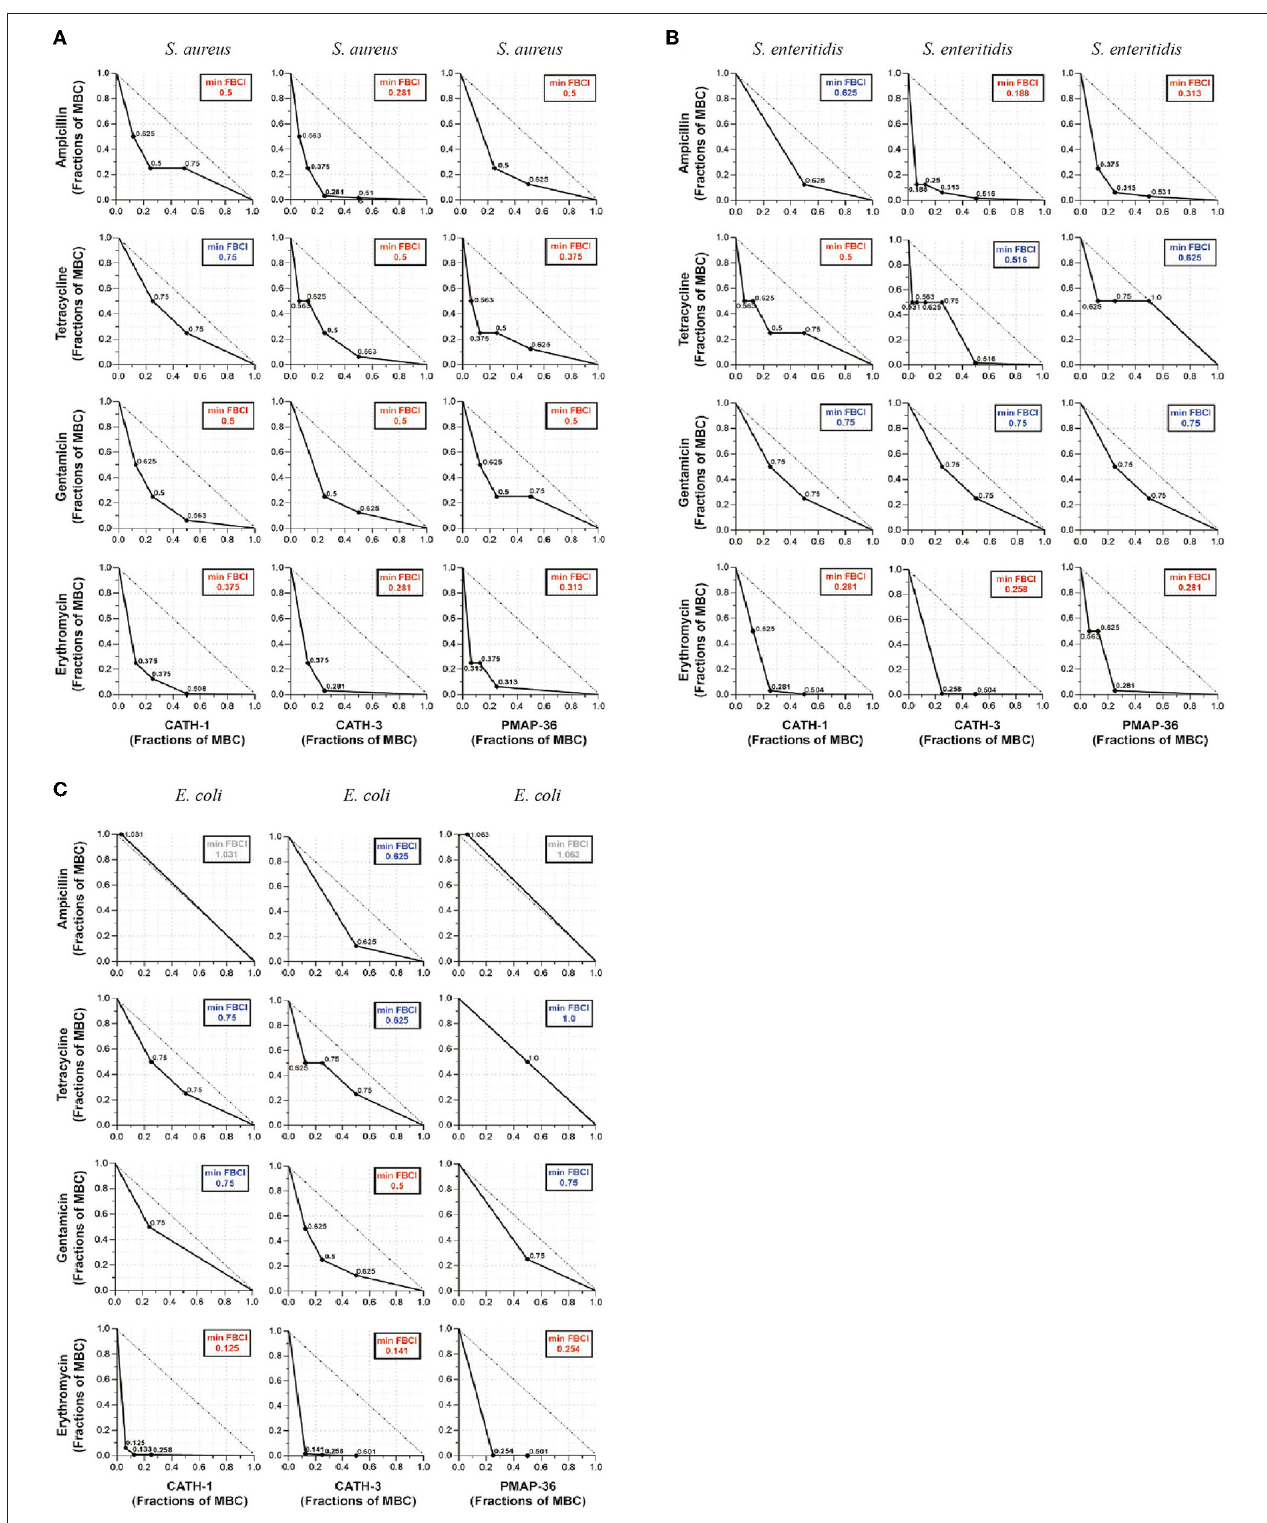
FIGURE 1 | Antibacterial effect of antimicrobial peptides combined with antibiotics against S. aureus , S. enteritidis, and E. coli . The isotope map shows the antibacterial effect of the combination of AMPs (CATH-1, CATH-3, and PMAP-36) and antibiotics (ampicillin, tetracycline, gentamicin, and erythromycin) against S. aureus (A) , S. enteritidis (B) , and E. coli (C) . The synergic antibacterial activity was determined by the fractional bactericidal concentration index (FBCI). FBCI values were defined as synergy for FBCI < 0.5, additivity for 0.5 < FBCI ≤ 1, indifference for 1 < FBCI ≤ 2, and antagonism for FBCI > 2. In each contour map, the colors, including red, blue, and gray, represent synergy, additivity, and independence, respectively.